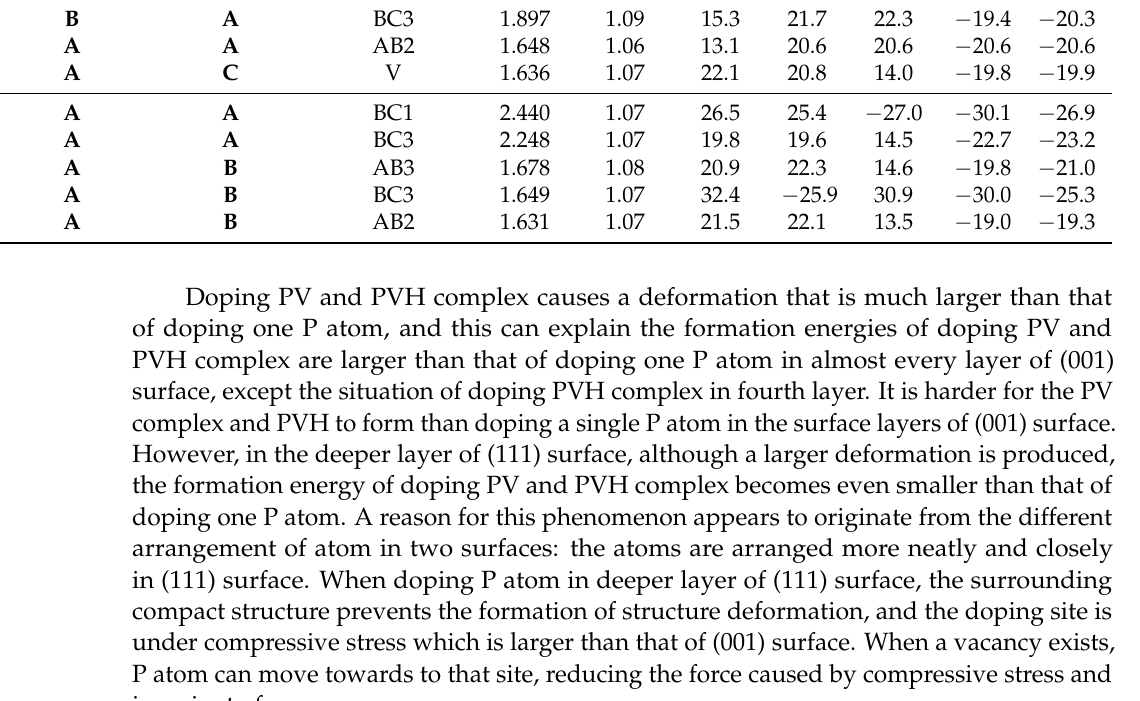
Table 4. Change of typical bond lengths of PVH complexes with the lowest formation energy in each layer. Surface Layer Position of P Position of V